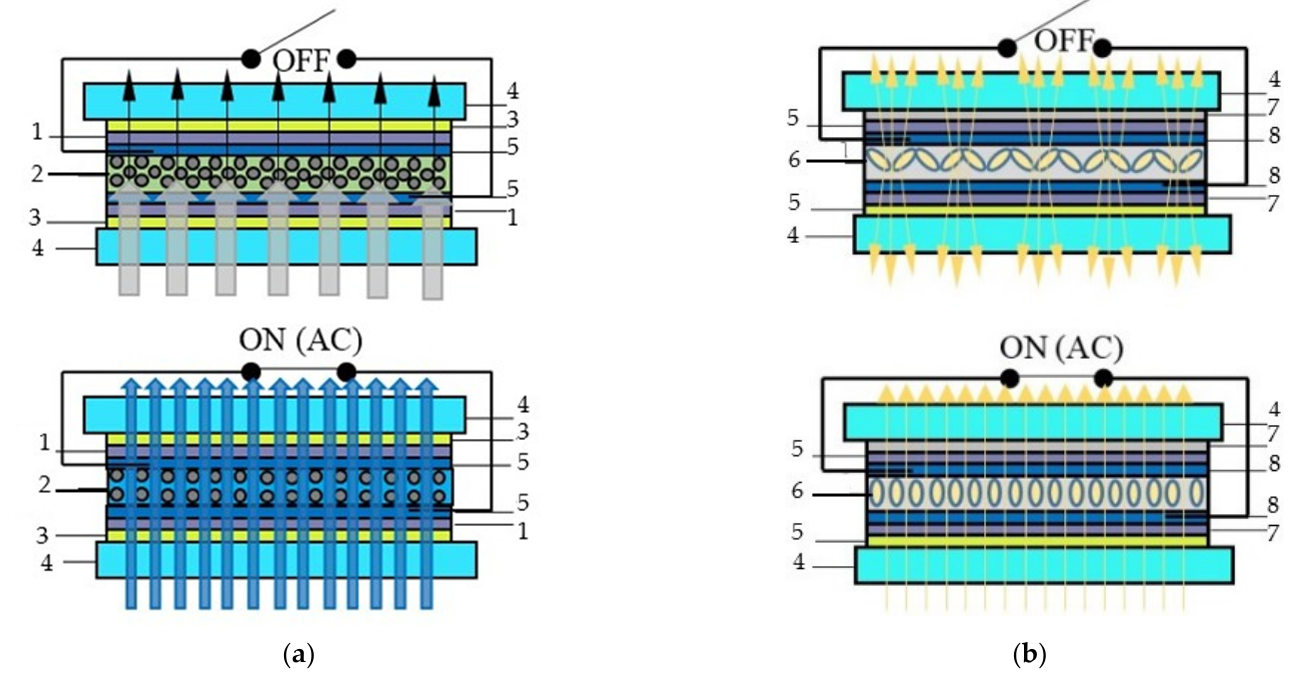
Figure 2. “Smart Windows” SPD and PDLC technology sandwich structures and operating principles: ( a ) SPD: off—light modulation mode, on—transparent mode; ( b ) PDLC: off—semi-transparent mode, on—transparent mode; 1—retaining film; 2—suspended particle; 3—adhesive layer; 4—glass; 5—conductor; 6—liquid crystal layer; 7—interlayer film; 8—liquid